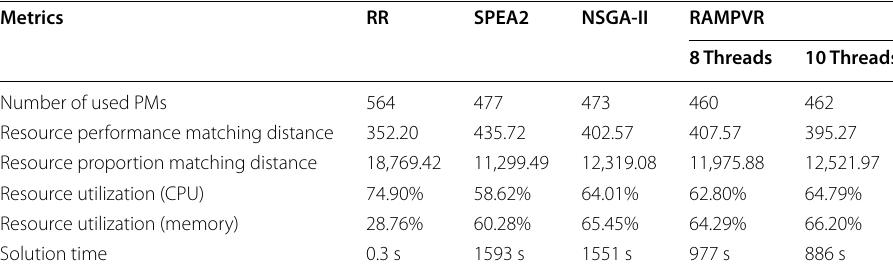
Table 2 Experimental results of resource allocation for S1 sequence Metrics RR SPEA2 NSGA‑II